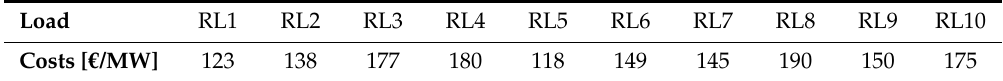
Table 3. Shedding costs of the responsive